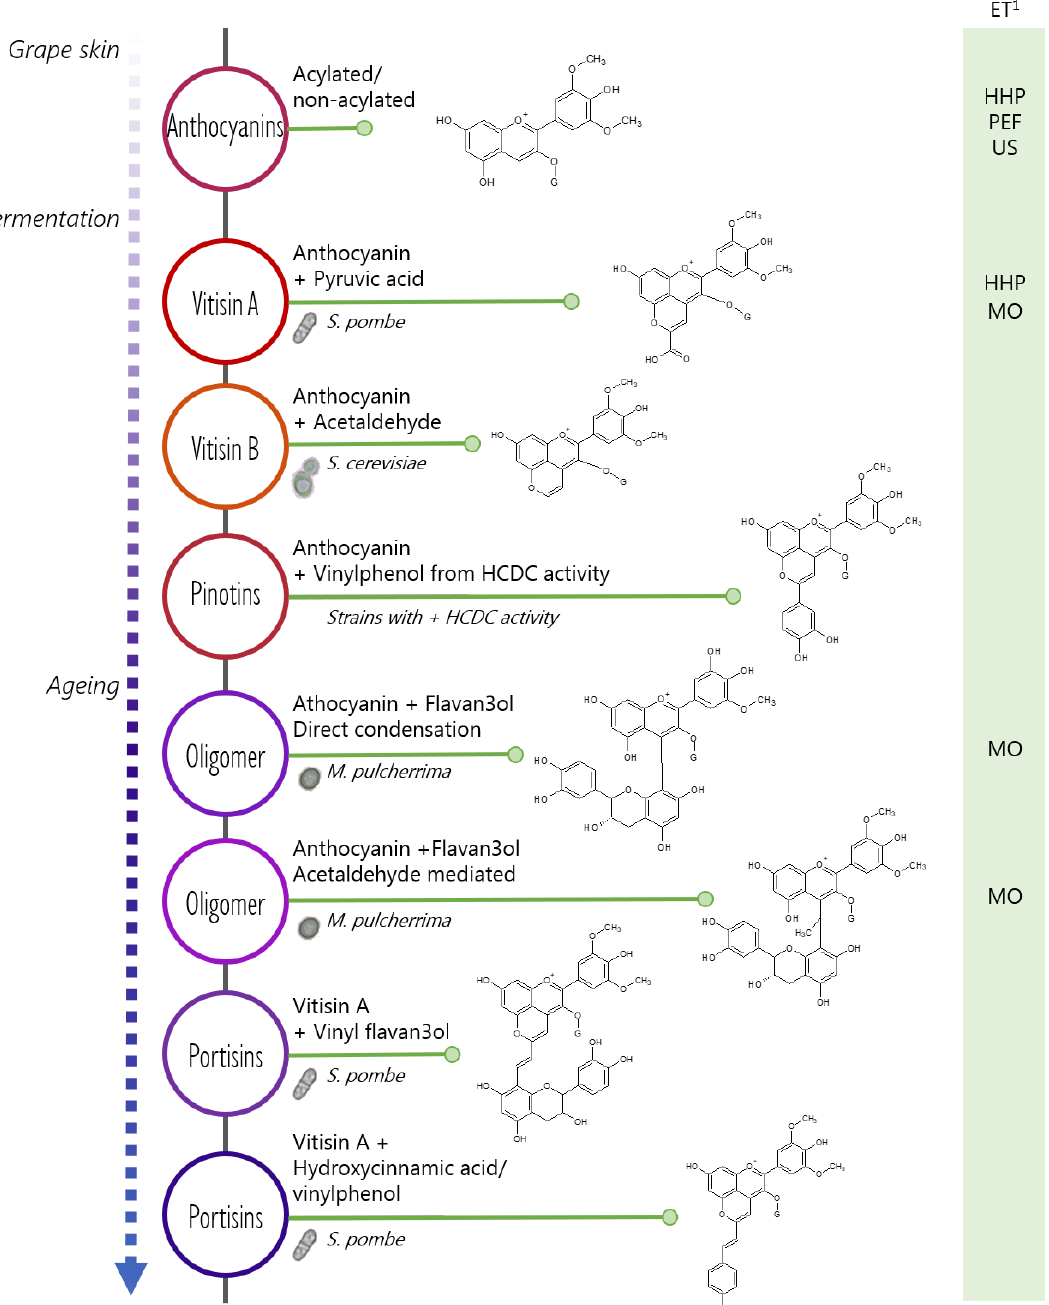
Figure 5. Example of red wine pigments and their occurrence during the different winemaking stages. From top to bottom the pigments shown in the figure are: malvidin-3-glucoside, malvidin-3-glucoside pyruvic acid (vitisin A), malvidin-3-glucoside-4-vinyl (vitisin B), malvidin-3-glucoside 4-vinylcatechol (pinotin A), dimer malvidin-3-glucoside-catechin, dimer malvidin-3-glucoside-ethyl-catechin, malvidin-3-glucoside-pyruvic acid vinyl catechin (portisin type A) and malvidin-3-glucoside pyruvic acid vinyl phenol (portisin type B). Yeasts species contributing to the formation of particular pigments are also indicated.